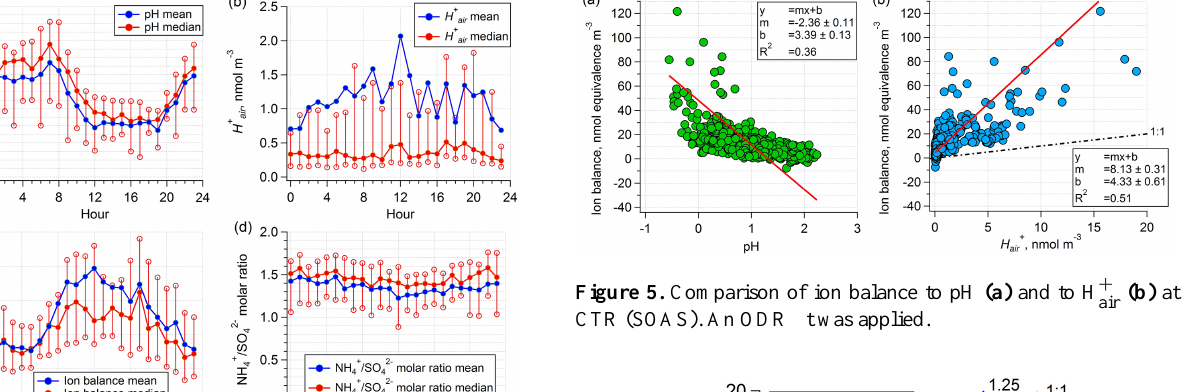
predicted by ISORROPIA- air / SO 2 − molar ratio (d) . Mean 4 4